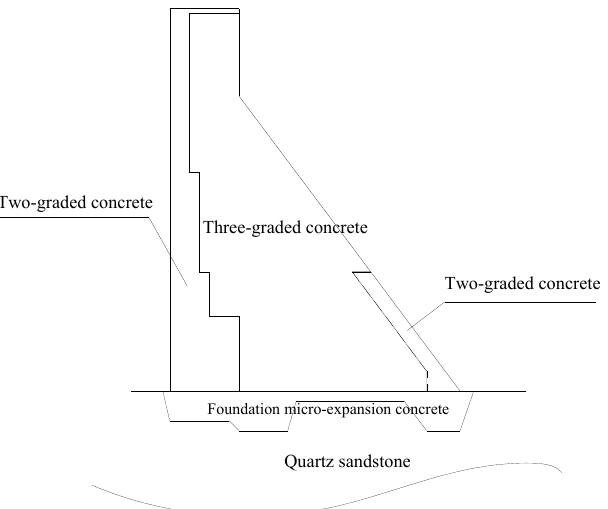
Figure 6. Section sketch and material partition diagram of No. 9 non-overflow dam section.